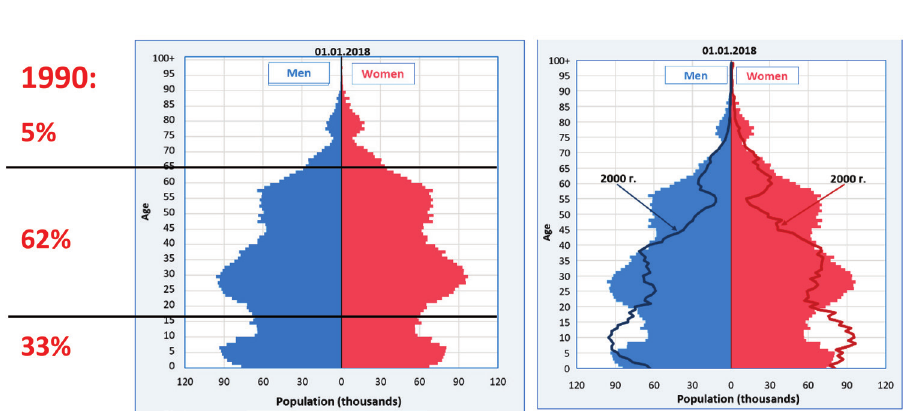
Figure 21. Population structure of Azerbaijan by sex and age, 2000 and 2018. Source: according to SSC